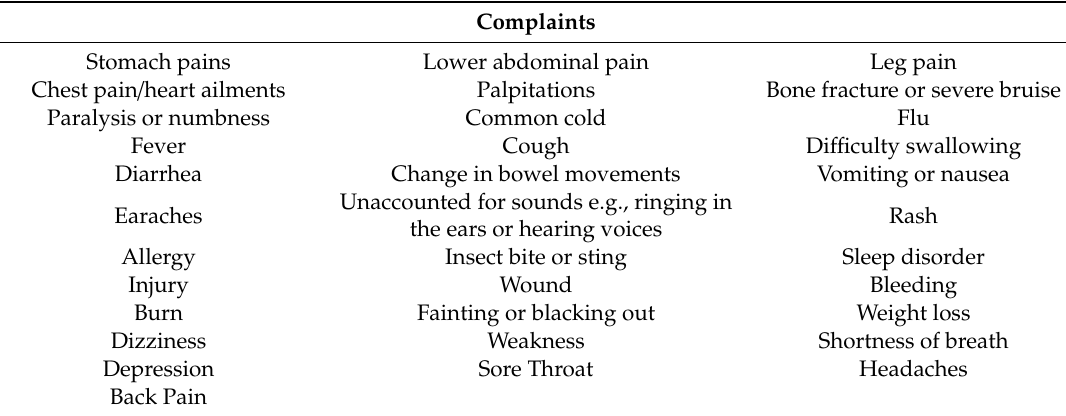
Table 1. Main complaints, symptoms, and reasons for consultation.